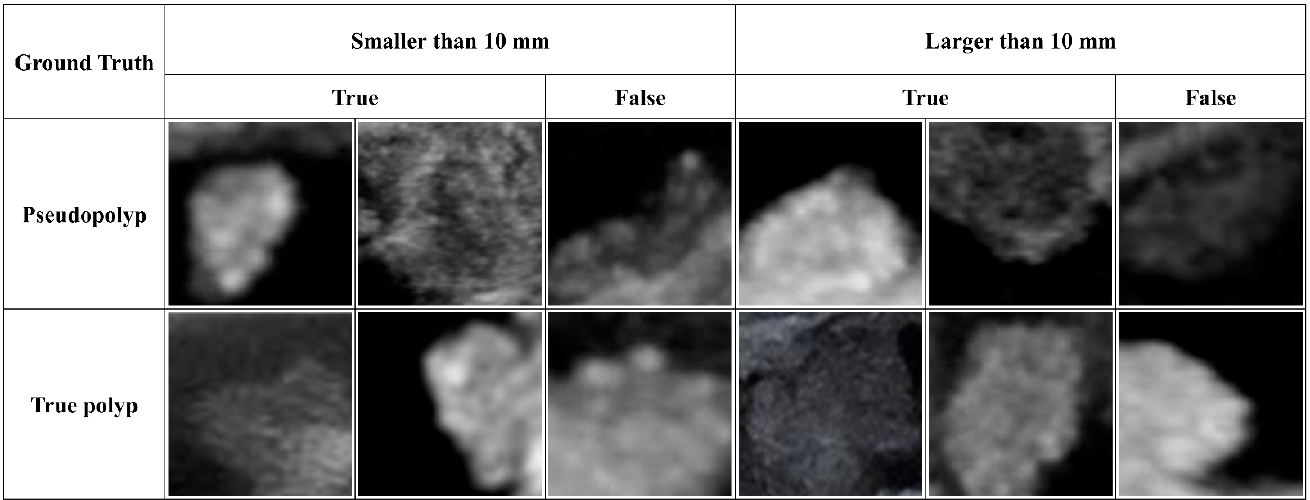
Figure 6. Model prediction results and corresponding images according to GB polyp size. The first and second rows are ultrasound images of pseudopolyps and true polyps confirmed through cholecystectomy, respectively.